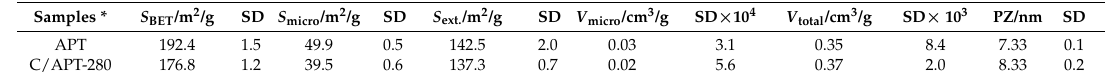
Table 1. Pore structure parameter of APT and C/APT-280.